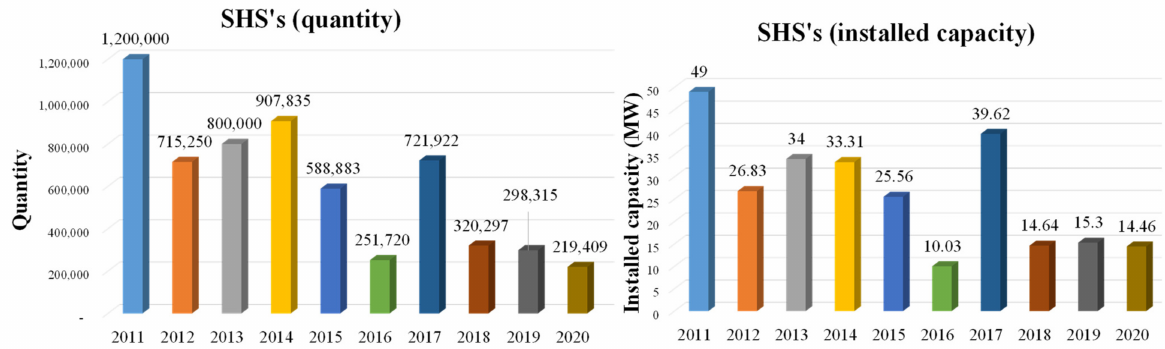
Figure 20. The historical installed quantity and capacity of solar home systems (2011-2019) (authors’ creation based on SREDA data